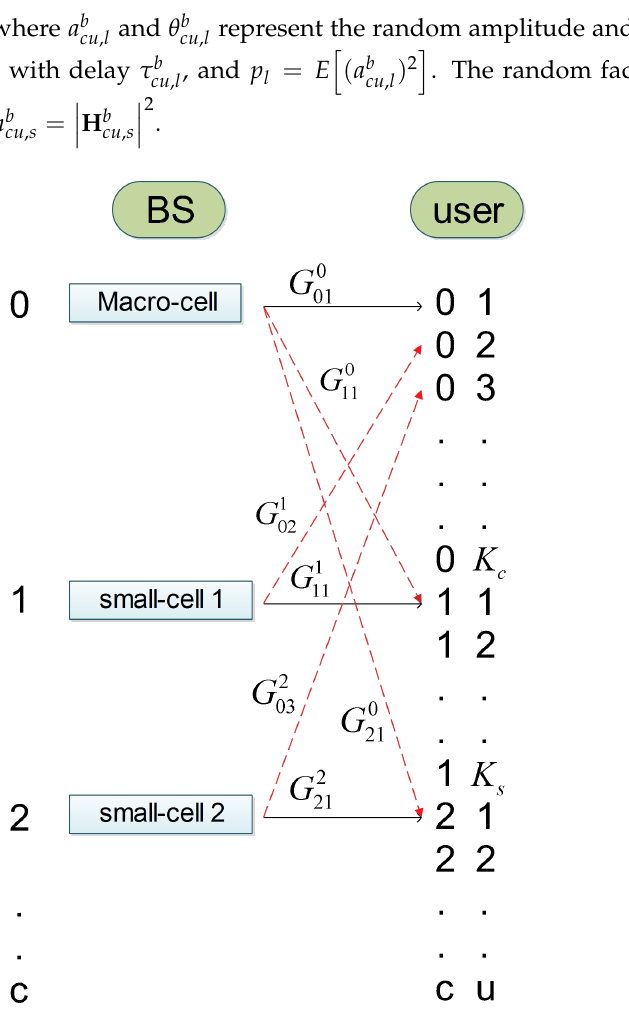
Figure 3. Notations for the channel gains of the wireless links between base stations and